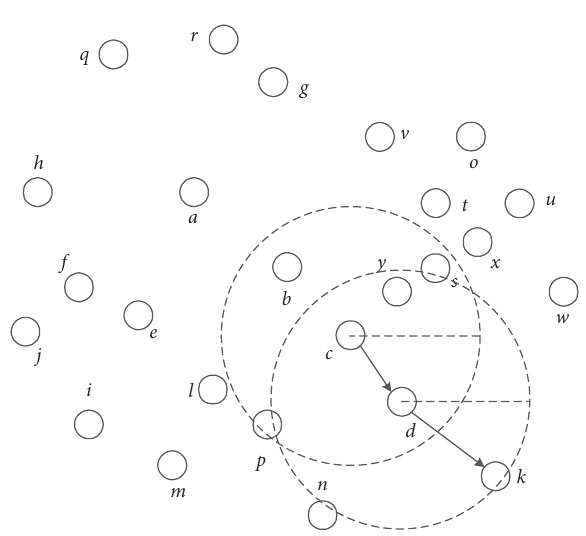
Figure 5: Example of random select